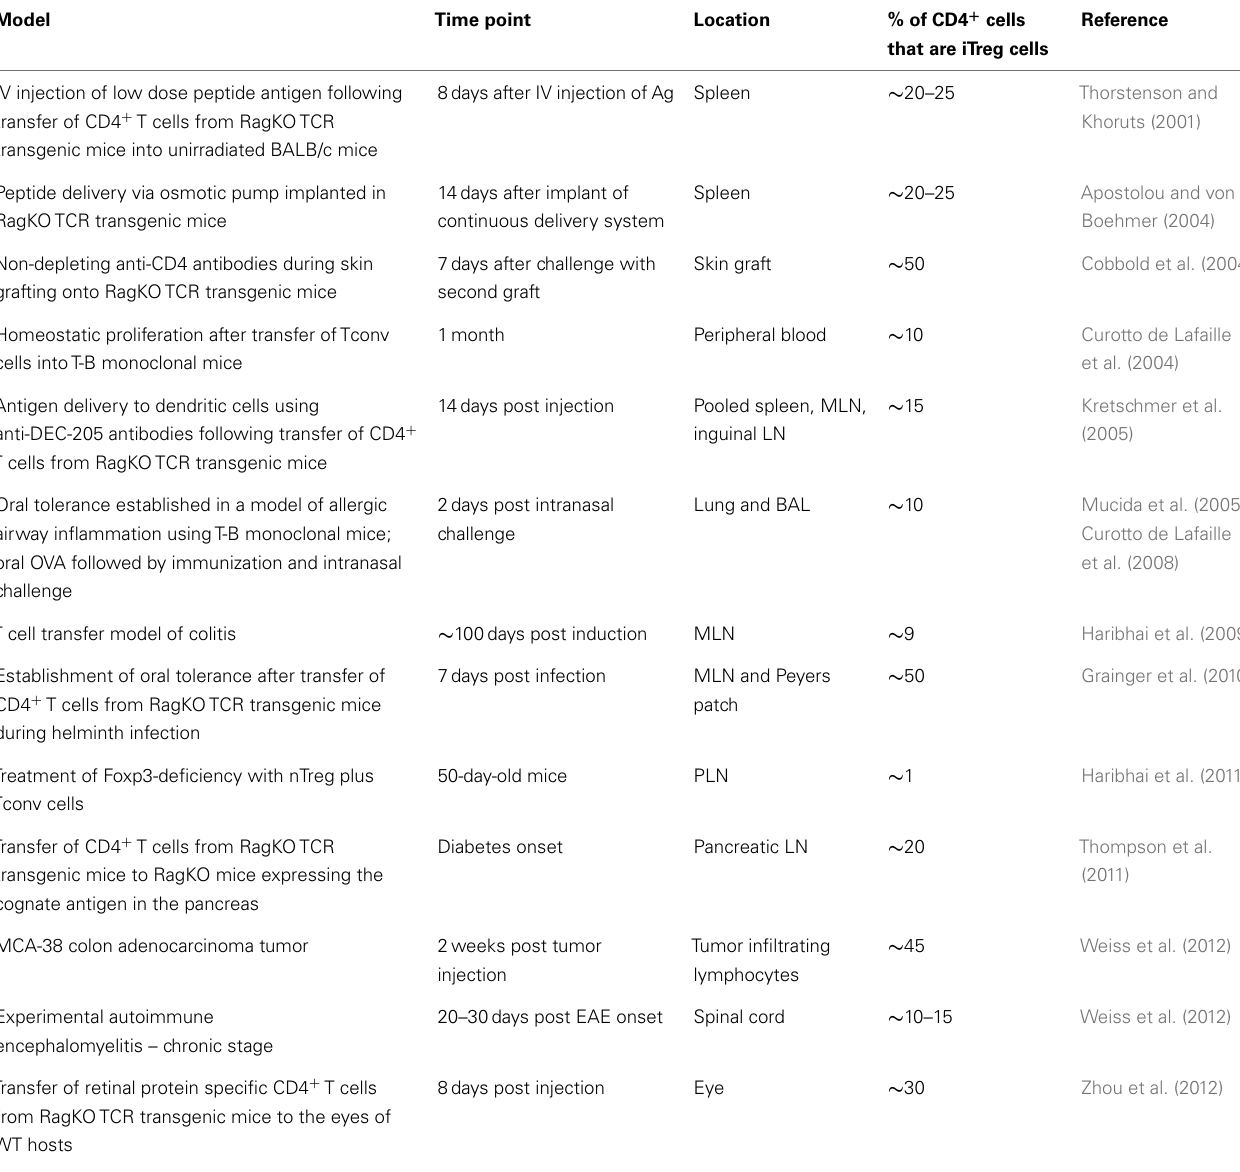
Table 1 | Models generating in vivo -derived iTreg